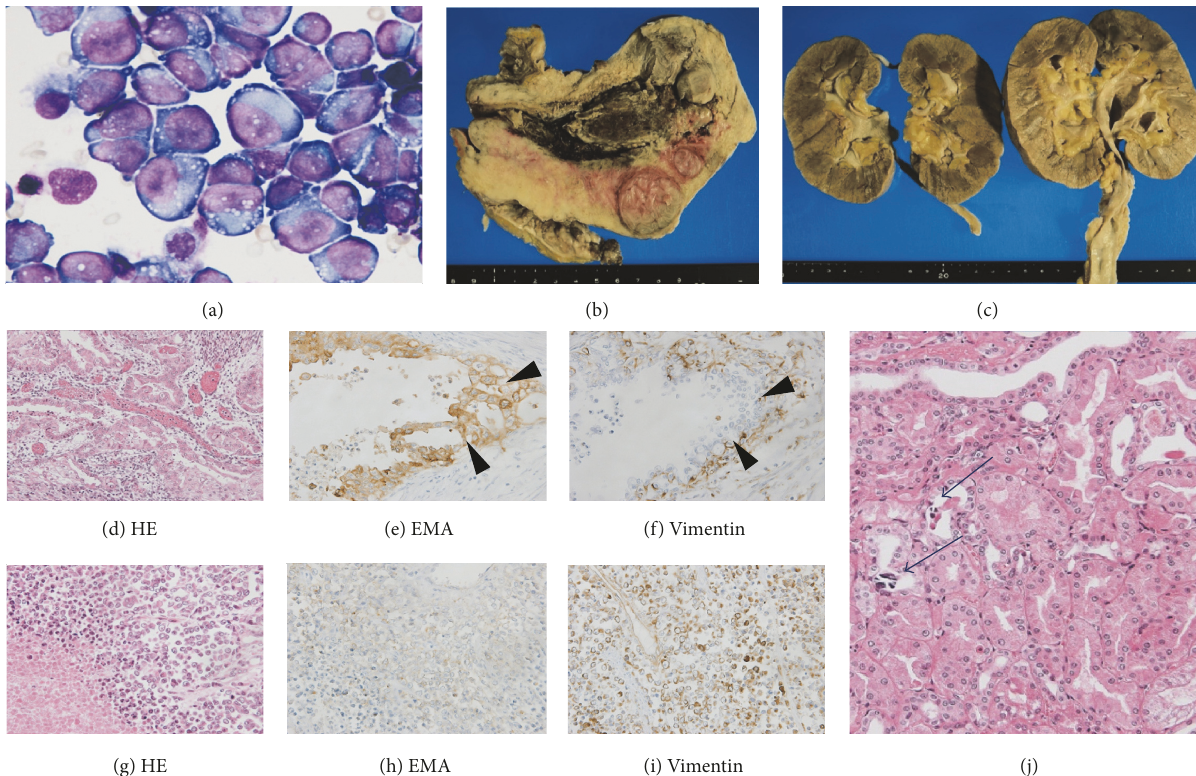
Figure 1: Histopathological findings of ascites and autopsy. (a) Cytomorphological evaluation of ascites revealed large abnormal cells mimicking lymphoma. (b, c) Autopsy showed an enlarged uterus. There was no apparent invasion in both kidneys. Small nodules were scattered throughout omentum. (d–i) Hematoxylin and eosin (HE) staining of the uterus showed two types of malignant cells (d, g) characterized by coexisting endometrial carcinoma and undifferentiated immature malignant cells. These endometrial malignant cells were positive for epithelial membrane antigen (EMA) (e) and negative for vimentin (f). Undifferentiated immature malignant cells were negative for EMA (h) and positive for vimentin (i). (j) HE staining of the kidney showed no malignant invasion and many small stones were seen in